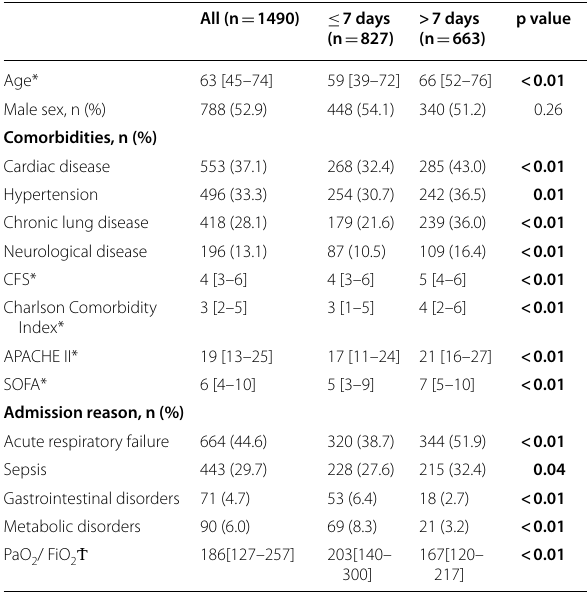
ICU stay. Table: Comparison of Short and Prolonged ICU stay